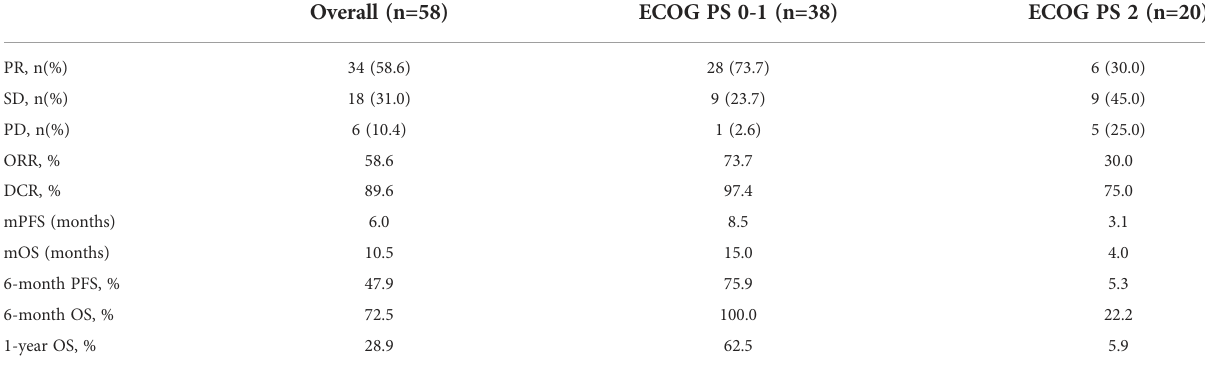
TABLE 5 Ef fi cacy in patients with different ECOG PS.